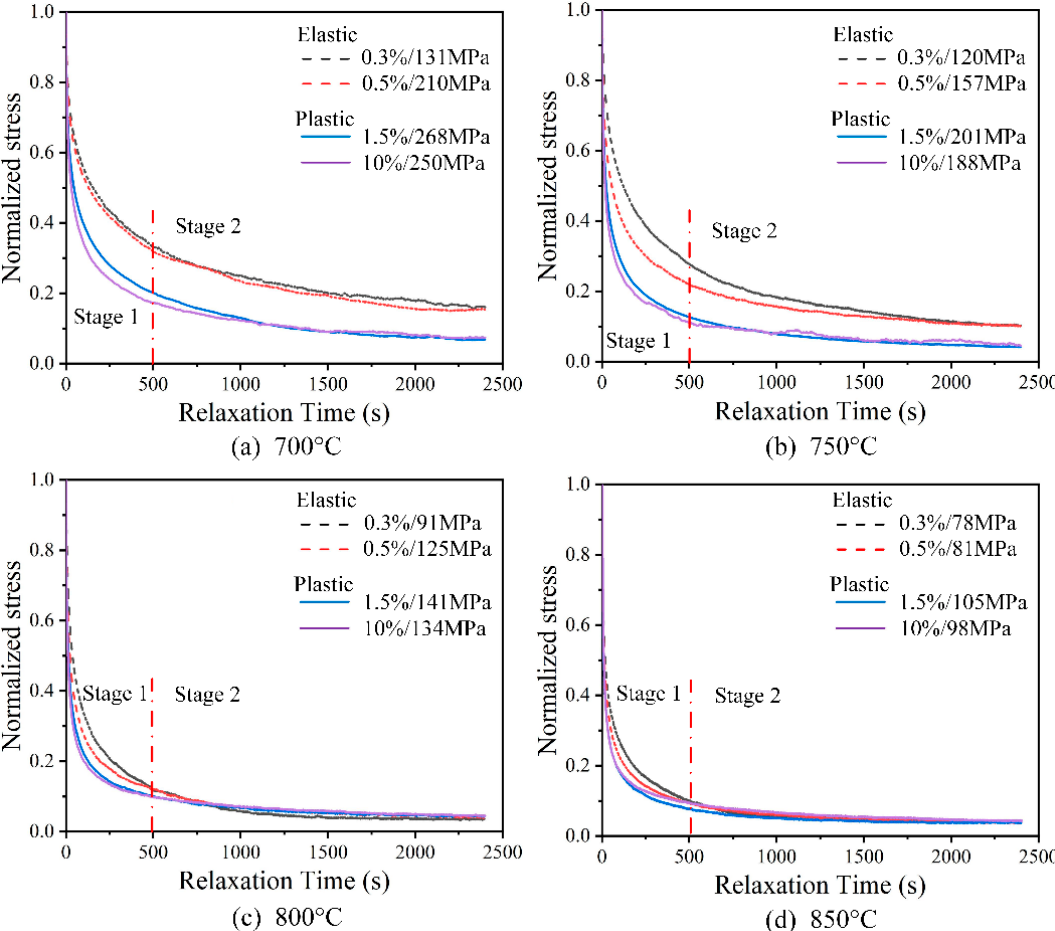
Figure 4. Normalized stress relaxation curves of Ti-6Al-4V alloy at different temperatures for 2400 s, ( a ) 700 °C, ( b ) 750 °C, ( c ) 800 °C and ( d ) 850 °C.